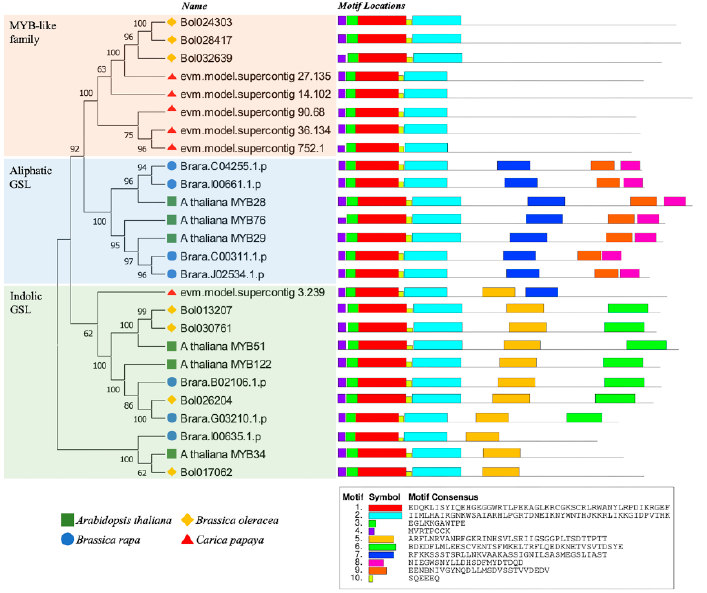
Figure 3. Phylogenetic relationship of MYB transcription factor genes and their corresponding motif structures in Brassicaceae and C. papaya using full-length protein sequences of 26 identified MYB genes .